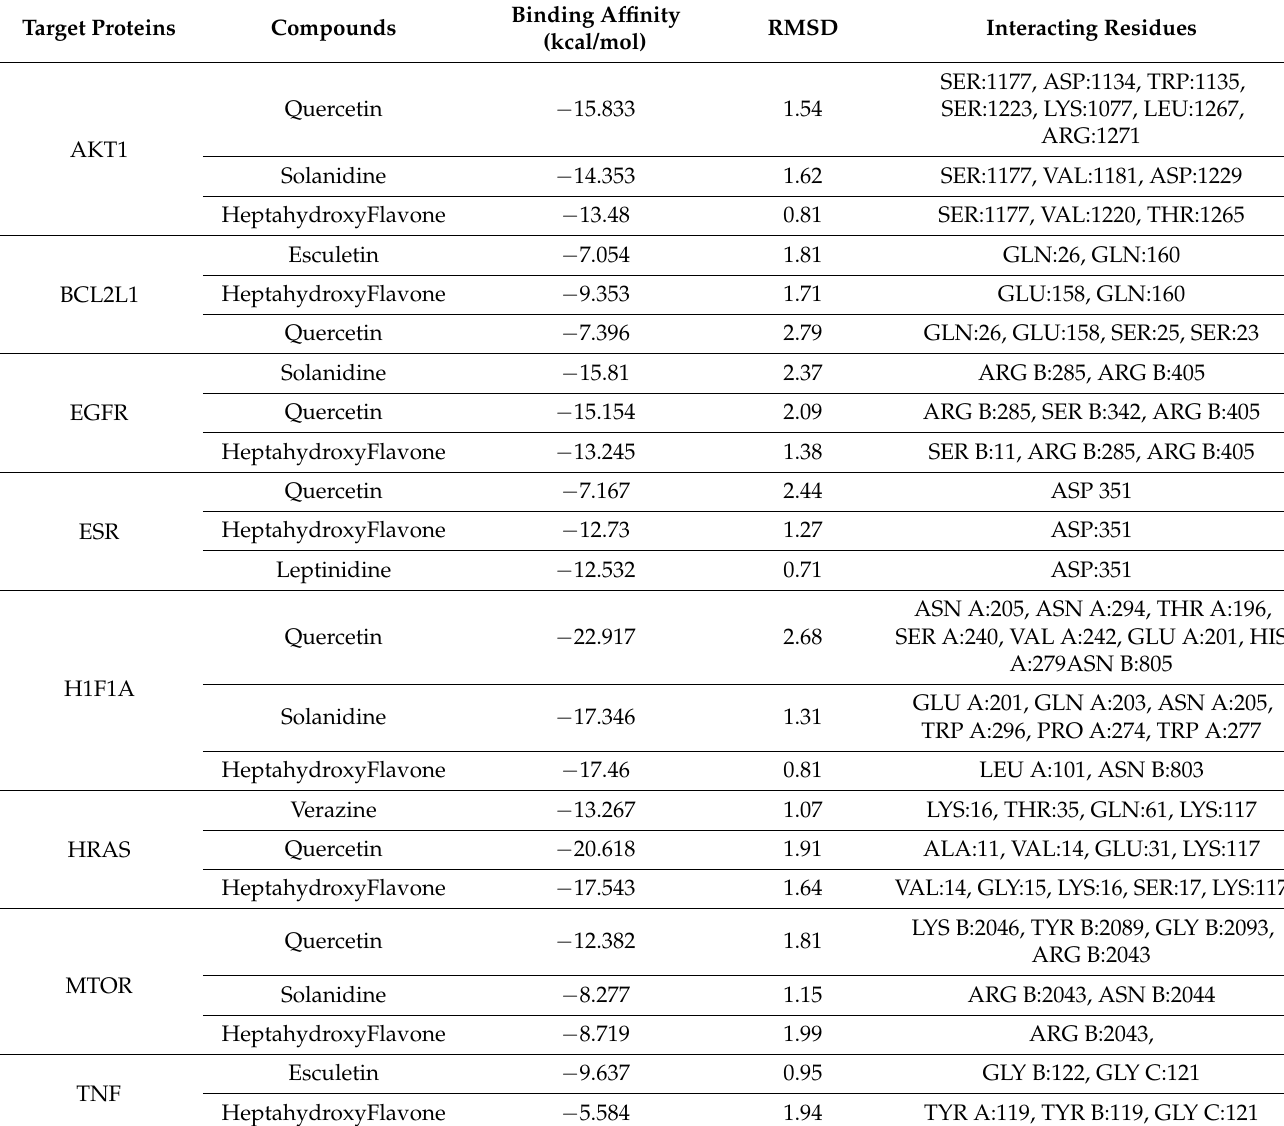
Table 2. Binding energies and interaction of potential docked